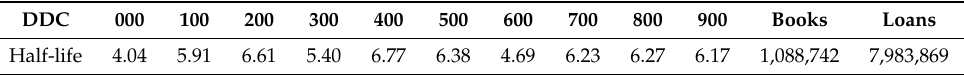
Table 7. Half-lives of books in each DDC class.